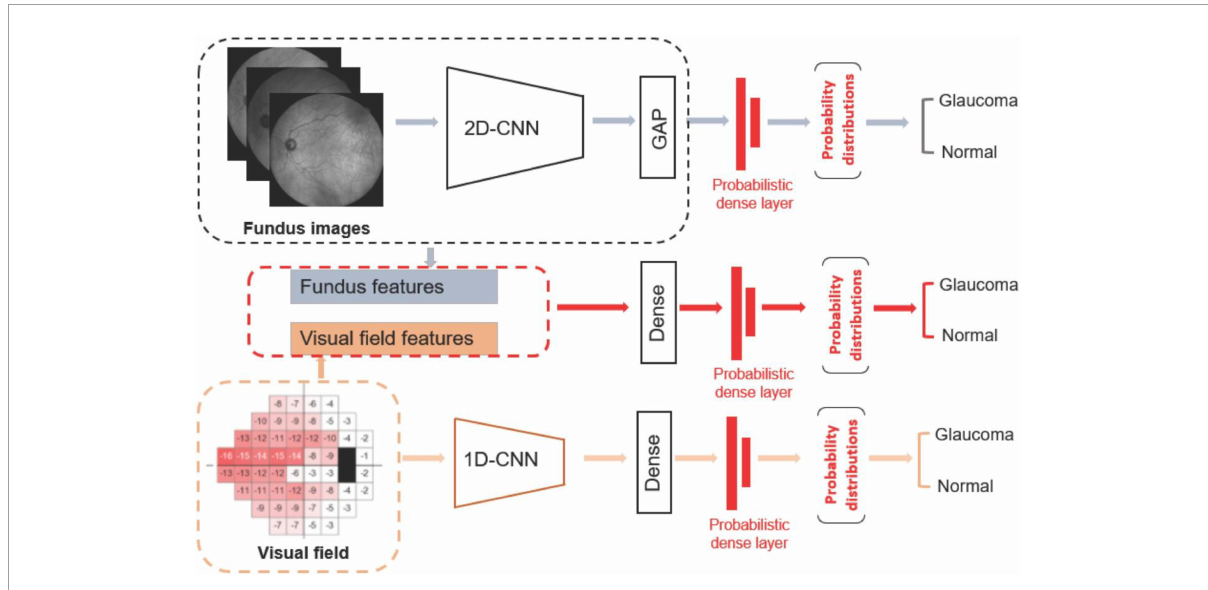
FIGURE1 Diagram of the deep learning models. Upper: Deep learning model based on fundus photograph. Middle: Hybrid model based on combined visual fields and fundus photographs. Lower: 1-D CNN model based on visual